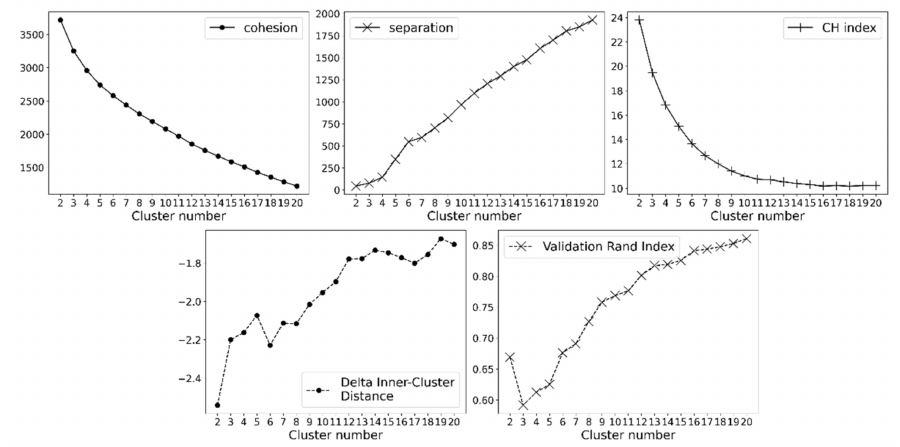
Figure 6. Evaluation metrics of K-means clustering for different cluster numbers for the pre-COVID- 19 dataset (top left: cohesion versus cluster number; top middle: separation versus cluster number; top right: CH index versus cluster number; lower left: delta inner-cluster distance versus cluster number; lower right: validation rand index versus cluster